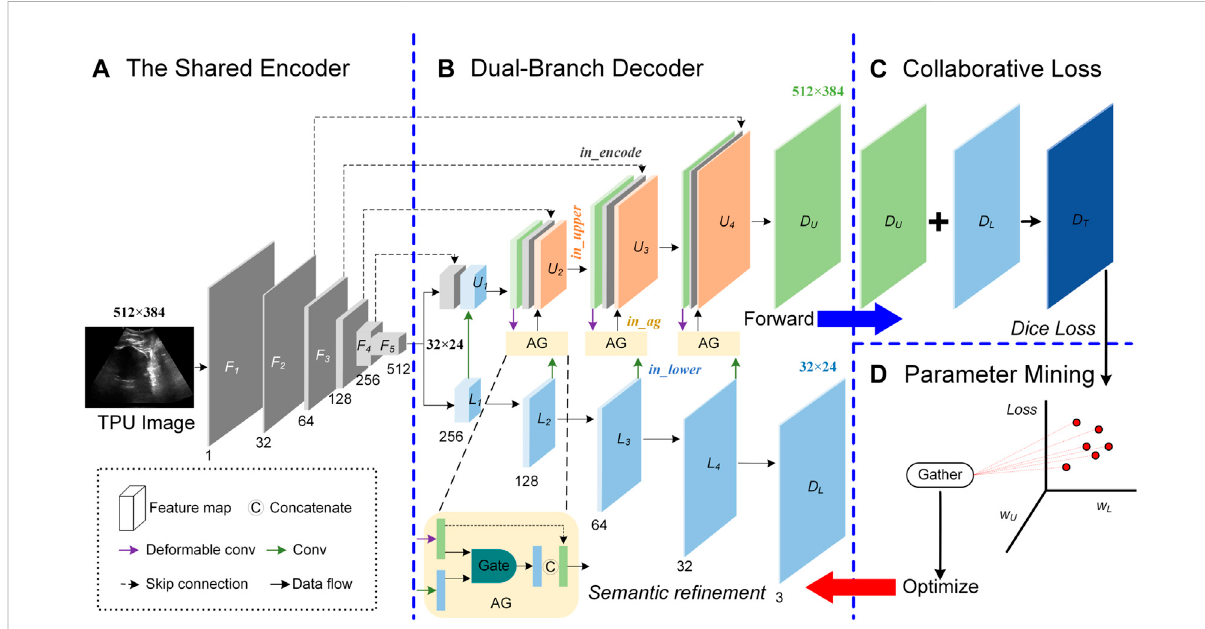
FIGURE. 2 Overview of the proposed Double Branch Segmentation Network (DBSN) structure. This DBSN architecture is composed of a shared encoder (A) ,adual-branchdecoder (B) ,thecollaborativeloss (C) andtheparametermining (D) .Inthedual-branchdecoder,featuremapsbetweentheupper (U) and lower (L) branches are fused with attention gates (AGs). In each block of the upper (U) branch, feature maps come from the encoder ( In_encoder ), the upper decoder ( In_upper ) and the AG ( In_ag ) that consider the feature map of the lower decoder ( In_lower